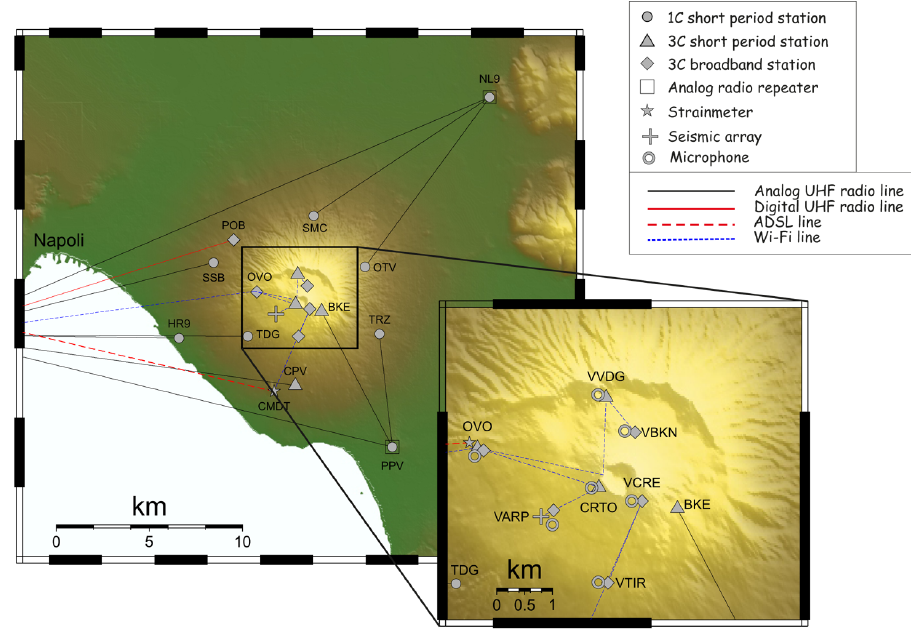
Figure 1. Map of Vesuvius permanent seismic monitoring network. Circles: short-period 1C stations; triangles: short-period 3C stations; di- amonds: broadband stations; stars: strainmeters; cross: seismic array (ARV1). The radio data transmission infrastructure is also shown. Black lines: analog radio UHF lines; red lines: digital UHF lines; blue dotted lines: Wi-Fi lines; red dashed lines: ADSL digital connection; black dashed lines: analog CDA data